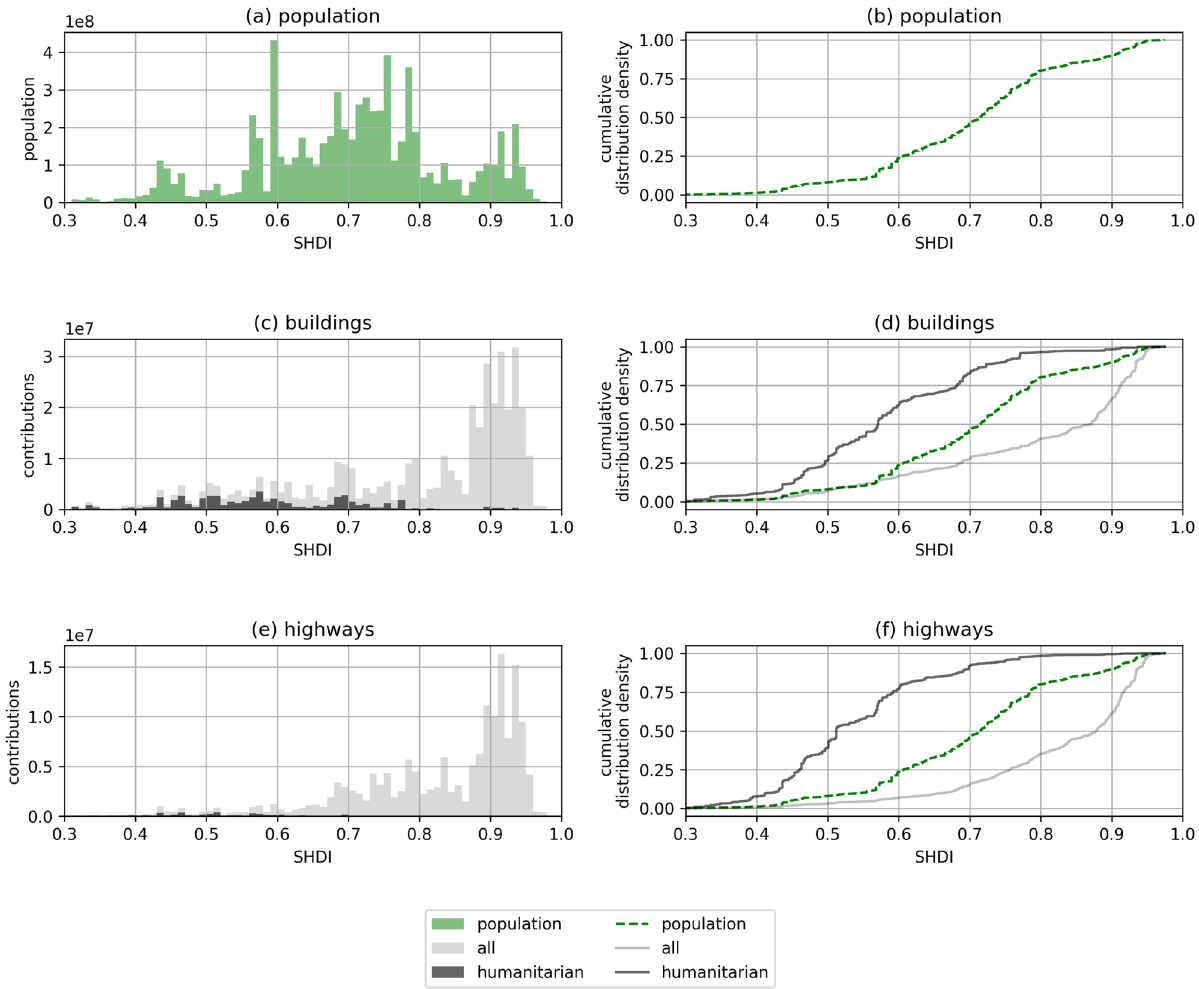
Figure 3. Frequency distribution and cumulative distribution density of ( a )–( b ) population and cumulative number of ( c )–( d ) buildings and ( e )–( f ) highways added to OSM between 2008/01/01 and 2020/05/20 in regard to to overall and humanitarian mapping activities and Subnational Human Development Index. Created using Matplotlib 3.3. in Python 3.7.5 (https ://www.pytho